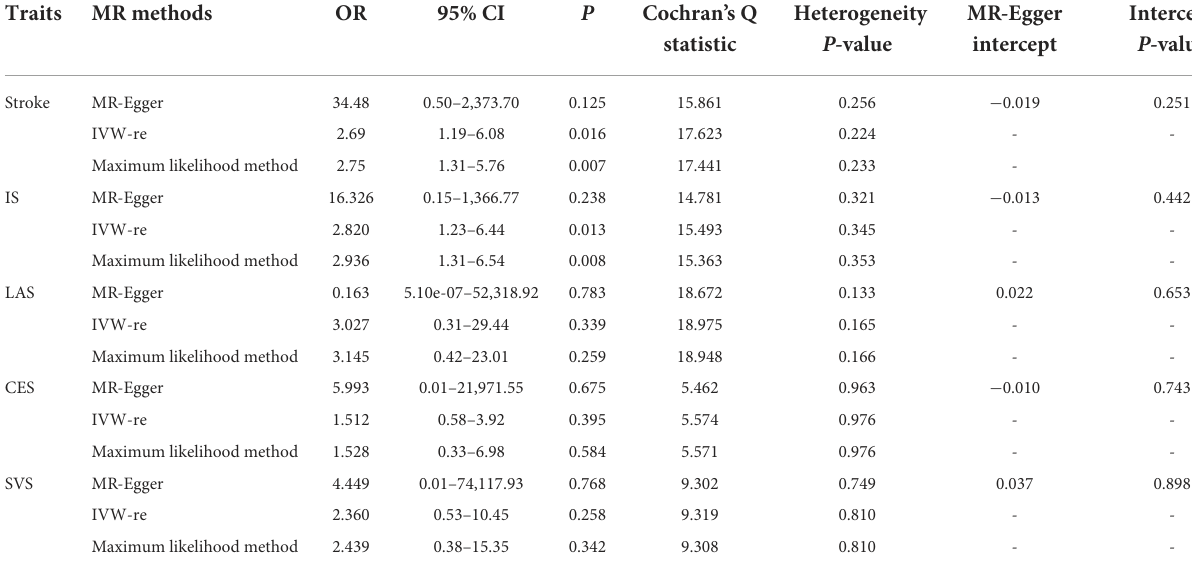
TABLE 1 MR estimates from each method of the causal effect of snoring on stroke and its subtypes.